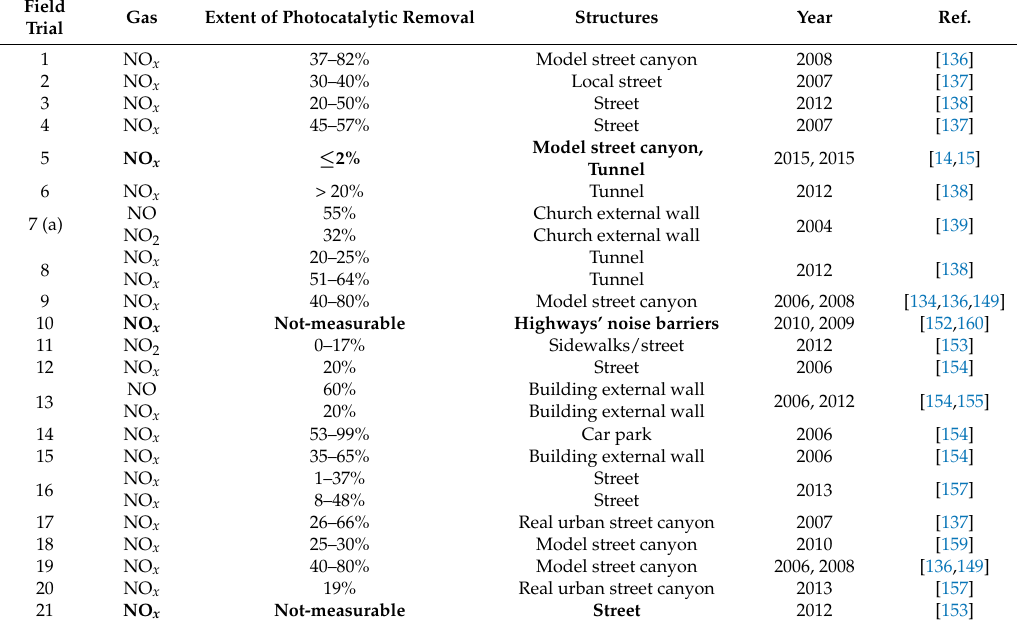
Table 10. Percent removal of NO x gases in field trials carried out with TiO 2 -based photocatalytic protocols in an open outdoor environment and under a variety of